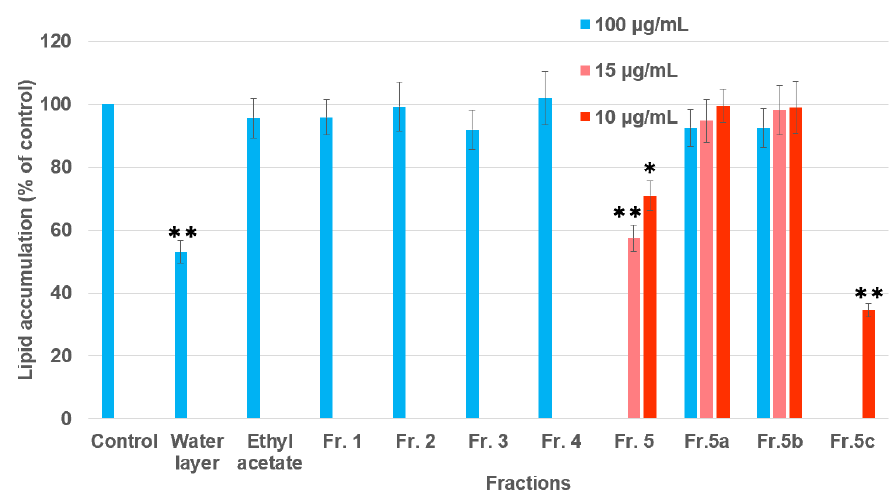
Figure 2. Effect of each fraction isolated from Moringa seeds on lipid accumulation during the differentiation of 3T3-L1 adipocytes. Fr. 5b and Fr. 5c were identified as compounds 1 and 2 , respectively, using LC-MS and NMR. (* p < 0.05 vs control, ** p < 0.01 vs. control). Data are expressed as mean ± SD (n = 3).